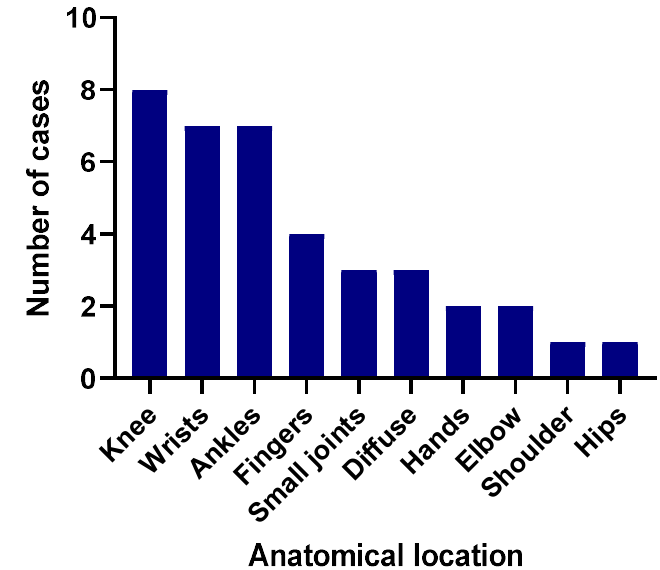
Figure 4. Anatomical location (x-axis) of joints affected by ZIKV-related arthralgia/joint pain, as reported in case studies ( n = 19 articles and n = 38 cases).